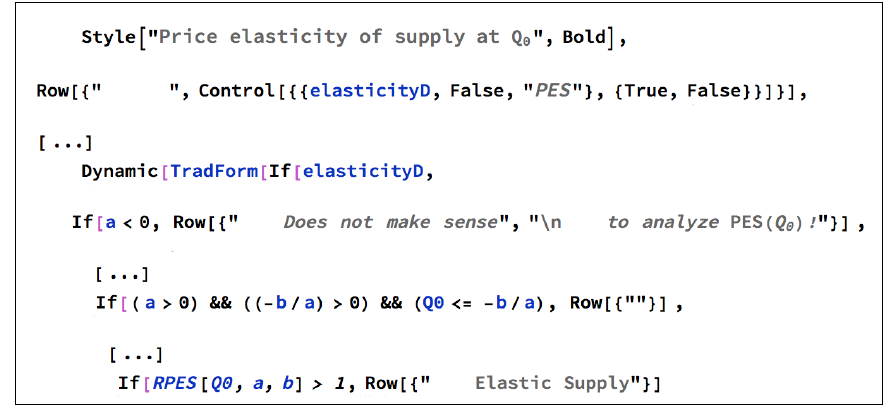
Figure 3. Code snippet of the PES(Linear)-Tool. This is part of the code that generates the analytical information about the price elasticity of